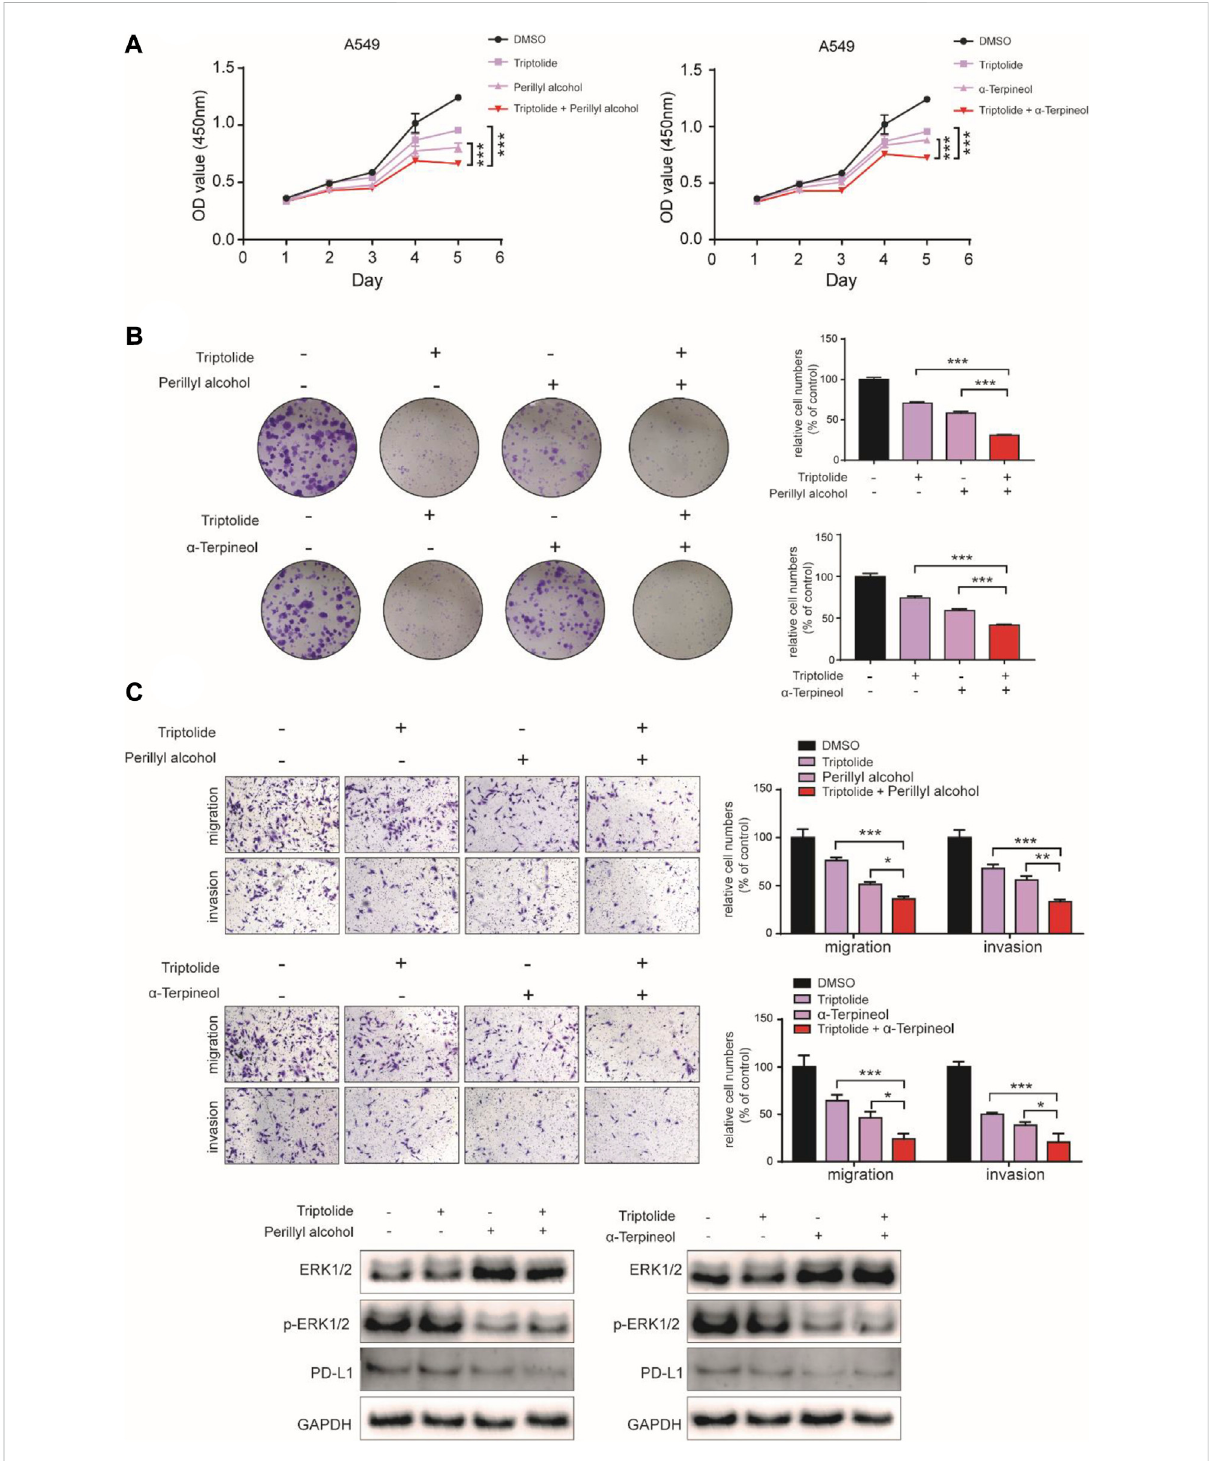
FIGURE 10 Synergistic Experimental Validation In Vitro . (A – C) : The cell proliferation, colony-formation and migration ability of the lung cancer cell A549 treated with triptolide (12.5 nM), perillyl alcohol (500 μ M) and α -terpineol (500 μ M) alone, or the combination of triptolide and perillyl alcohol/ triptolide and α -terpineol for up to 5 days were determined by CCK-8 assay (A) , colony-formation assay (B) and transwell assay (C) , respectively. D Western blot assay was carried out to measure the expression of ERK1/2, p-ERK1/2 and PD-L1 in A549 cell treated with triptolide (12.5 nM), perillylalcohol(500 μ M)and α -terpineol(500 μ M)alone,orthecombinationoftriptolideandperillylalcohol/triptolideand α -terpineol.Bars,SD;* p < 0.05, ** p < 0.01, *** p <